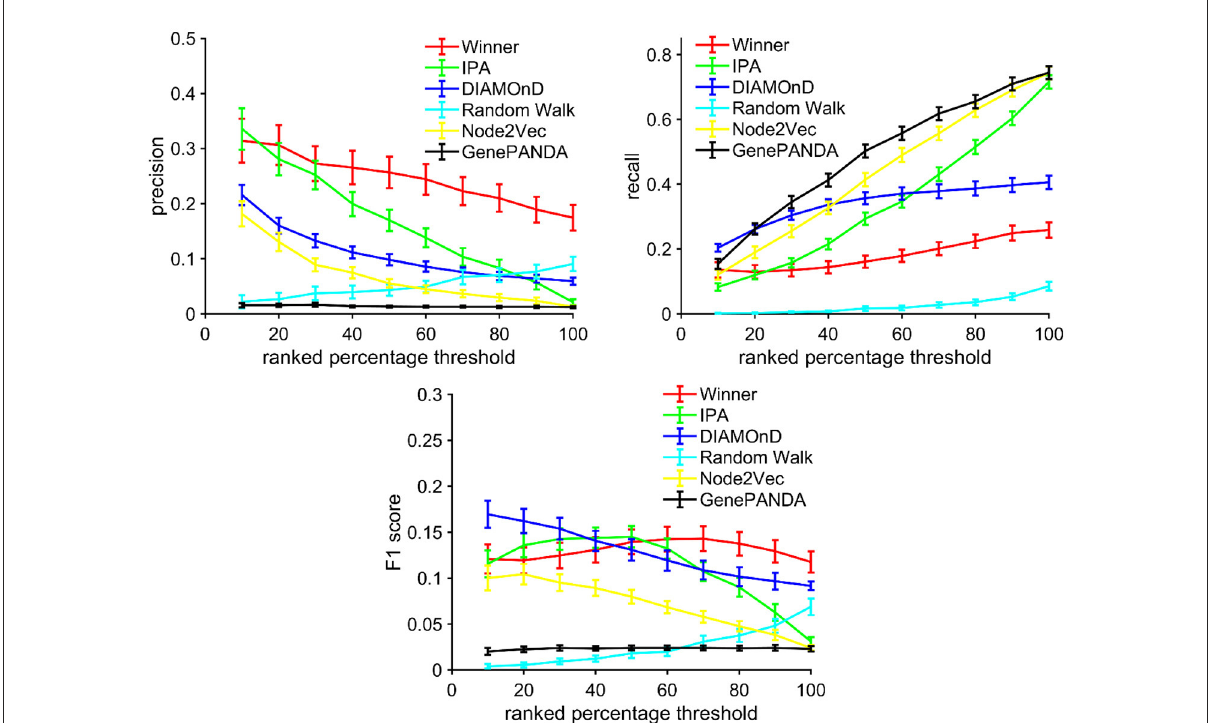
FIGURE8 Benchmark: WINNER expansion more accurately identifies the addition of new genes to established networks. The pathway networks in KEGG (https://www.genome.jp/kegg/network.html) release 50 was expanded via WINNER (i.e., calculation of the WINNER expansion p -value), Ingenuity Pathway Analysis (IPA), DIAMoND, Random Walk, Node2Vec, and GenePANDA. Then, the expanded networks were compared to the updated network in KEGG release 85 to determine the precision, recall, and F1 scores for each expansion